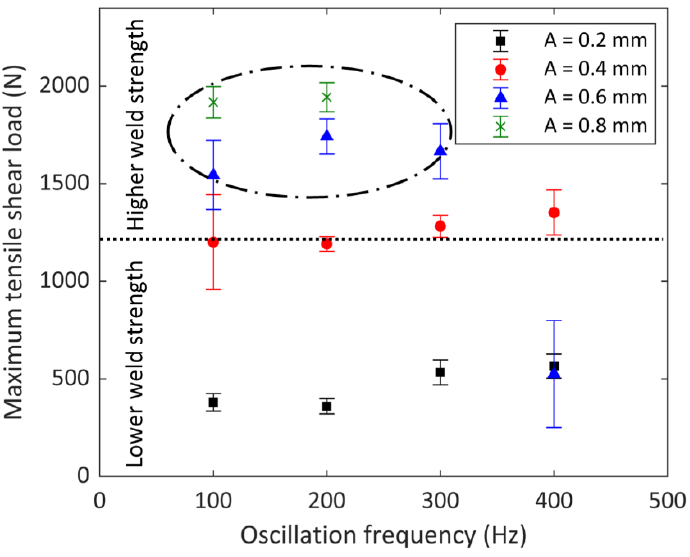
Figure 13. Variation in maximum tensile shear force versus oscillation parameters (laser peak power = 750 W, PRR = 20 Hz, PW = 10 ms, V w = 2 mm/s).